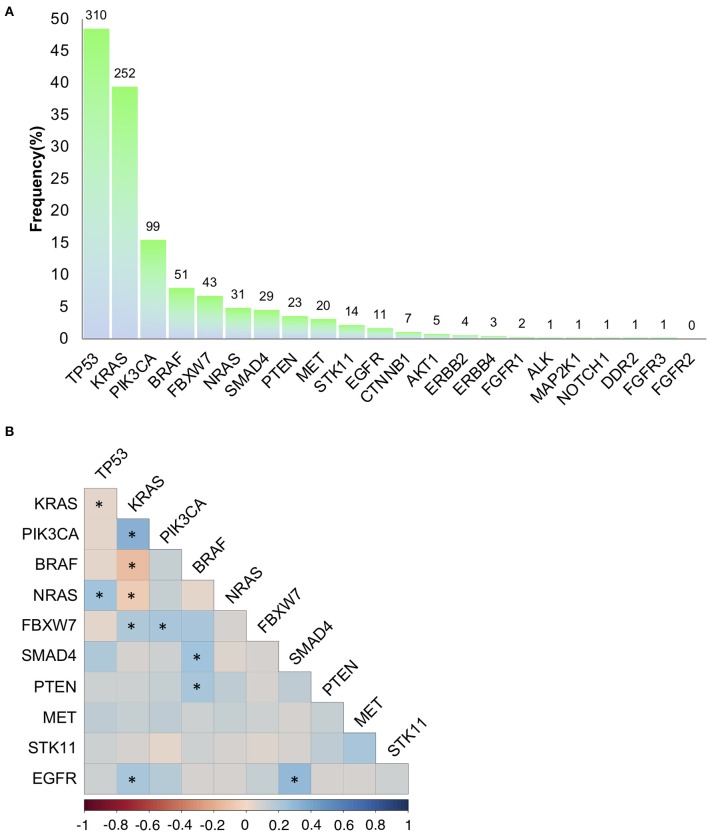
Mutation frequencies and pairwise associations. (A) Mutation rates (and absolute numbers of the bars) in 639 metastatic colorectal cancers. (B) Correlation Plot describing pairwise association of the mutations occurring on the 11 genes with a mutation frequency >1.5% (mutation number >10). Statistical analysis is given Table 1. *p < 0.05.